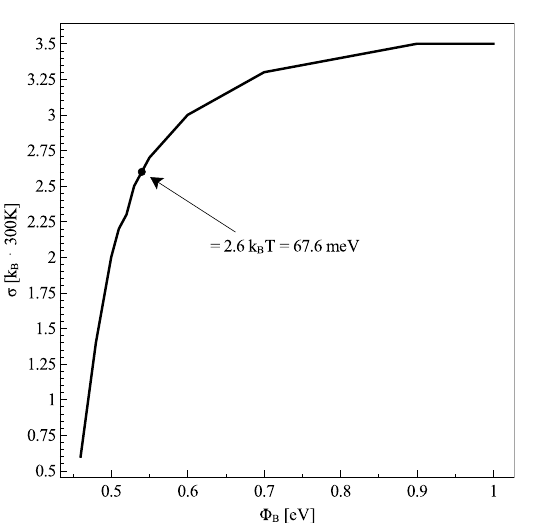
Figure 2. Dependence of the fitted Gaussian DOS width σ on the injection barrier Φ B . The dot on the curve identifies the σ value which simultaneously yields in the best fitting of OTFT transfer characteristic curves and of MIS capacitor CF curves. Experimental data are taken from ref. 4 and refer to MIS capacitors based on the prototypical n-type polymer